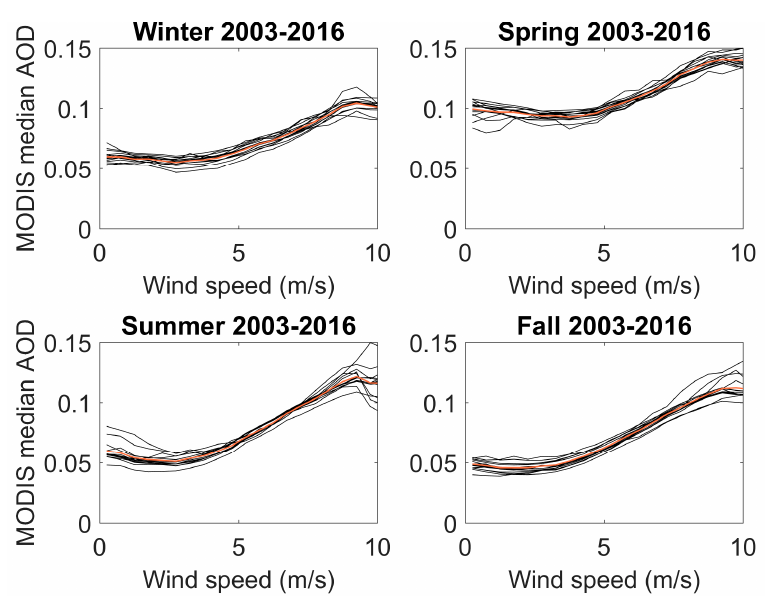
Figure 4. MODIS-adjusted median AOD (555 nm) versus surface wind speed, subdivided with respect to season, for each year of the period 2003–2016. The orange solid line in each figure denote MODIS mean AOD, averaged over the investigation period.